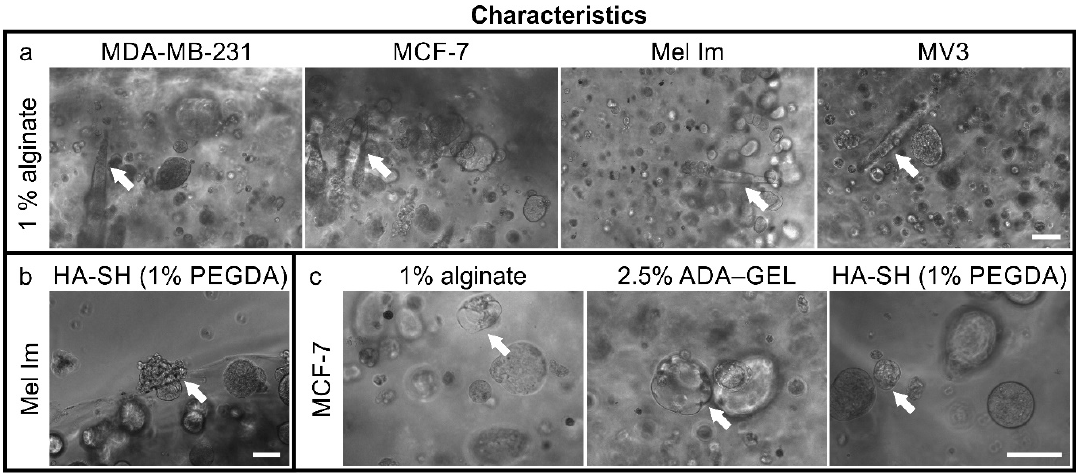
Figure 7. Cellular characteristics on day 14 in hydrogels: ( a ) channels of cells within 1% alginate aligned from the center to the outside, indicated by the arrows; ( b ) Mel Im that burst the surface of the hydrogel, indicated by the arrow; ( c ) formation of mammary-gland-like structures of MCF-7 in different hydrogels, indicated by the arrows; scale bars = 100 µm.